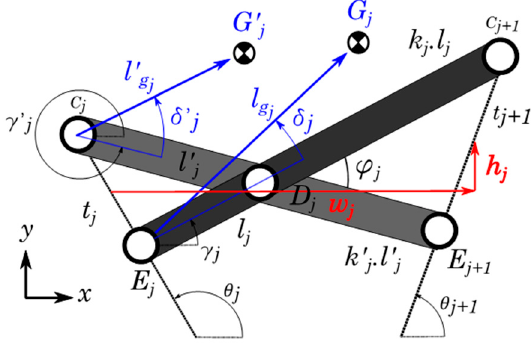
Figure 4. Representation of the arbitrary locations of mass centers of a generic SLE.